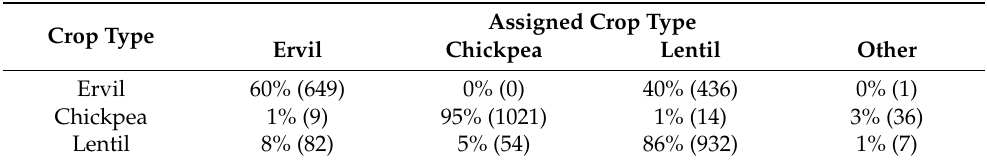
Figure 9. rVSI AM of the three gathered images at 16 m and the identification of the studied zones to calculate the accuracy of the proposed method. ( a ) rVSI AM image n° 1, ( b ) rVSI AM image n° 2, ( c ) rVSI AM image n° 3. The crops in the images from top to bottom lines are ervil, chickpea, and lentil. Table 6. Confusion matrix of the three studied zones for the three rVSI AM using the threshold values as a classification option.